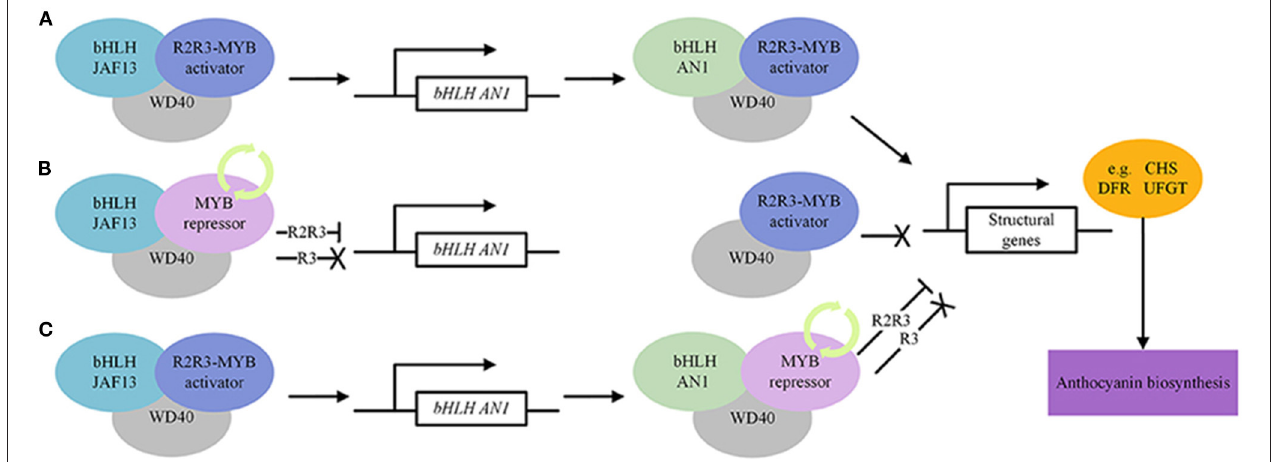
FIGURE 3 | Regulatory transcription factors in anthocyanin biosynthesis pathway. MYB, bHLH and WD40 modulate the expression of structural genes. (A) Activate regulation of anthocyanin biosynthesis. (B) Repressive regulation of anthocyanin biosynthesis. MYB repressors compete with MYB activators for bHLH JAF13. (C) Repressive regulation of anthocyanin biosynthesis. MYB repressors compete with MYB activators for bHLH AN1. The “ → ” means activation, “— | ” means repression and “X” means inactivation.